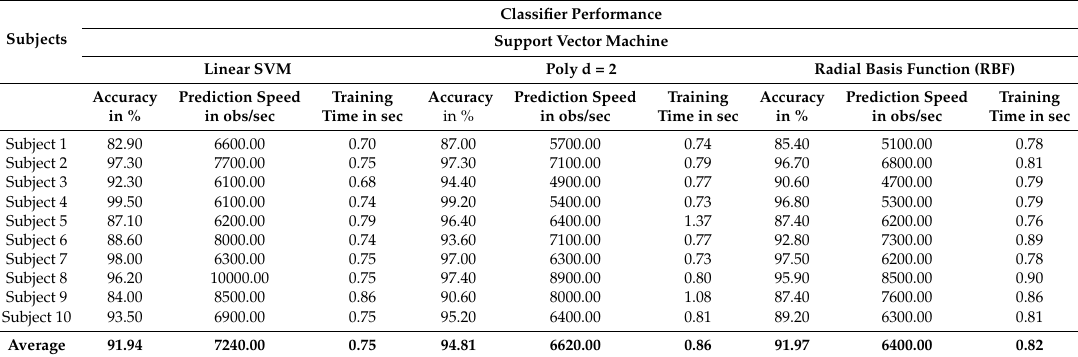
Table 2. Identification results using linear and kernel-based (polynomial d = 2 and radial basis function) support vector machine (SVM) including accuracy, prediction speed, and training time with 18D feature space.